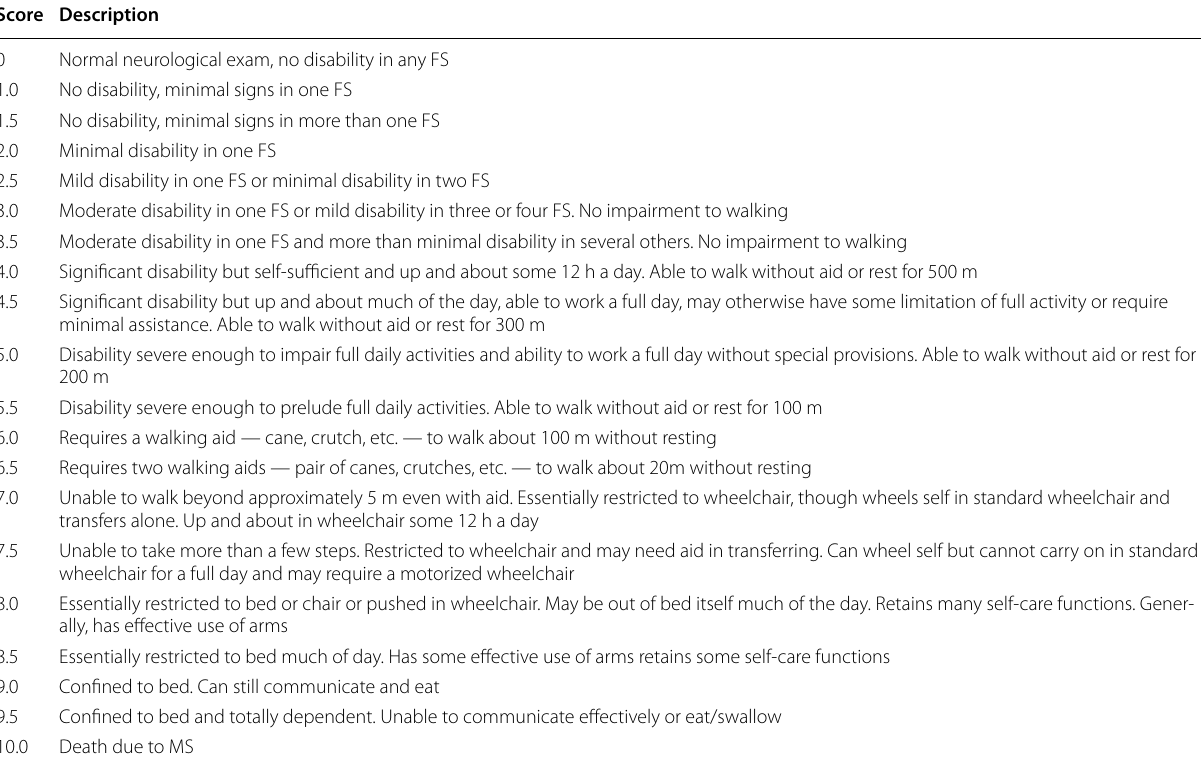
Table 1 Expanded Disability Status Scale (EDSS)